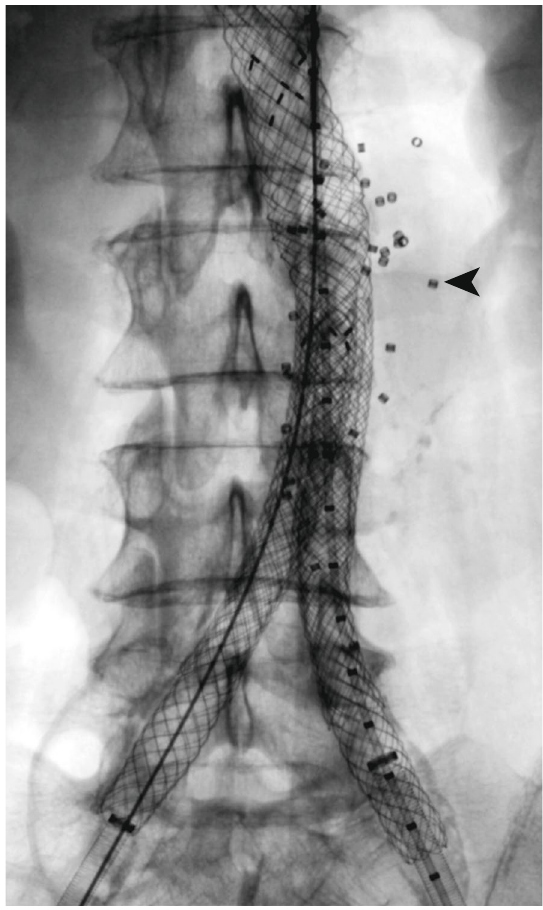
Fig. 4 Completion fluoroscopic image post aortic endograft (Lombard Altura) deployment and implantation of 31 shape memory polymer devices, with a total expanded embolic material volume of 38.75 mL, based on 1.25 mL per device. The small proximal radiopaque markers indicate the positioning of the devices throughout the aneurysm sac behind the endograft (black arrow indicates a single device/marker)